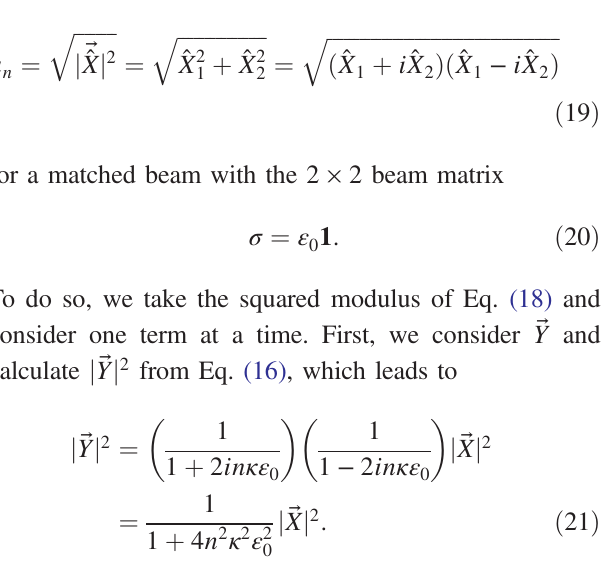
FIG. 1. Amplitude of the beam centroid (in units of the turn number n , parametrized as θ ¼ 2 κε 0 n with parameters ε 1 and κ ¼ 0 . 1 and for two values a 0 ¼ initial